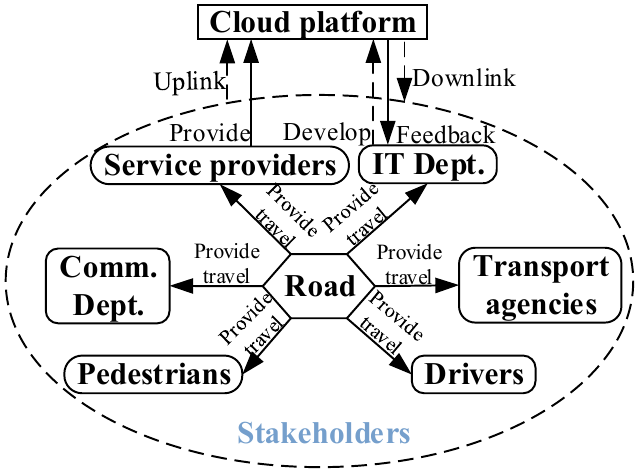
Figure 13. Function model of stakeholders. (c) Function modeling of the collision-warning service system Collisions usually occur between vehicles or between vehicles and pedestrians. We built the function model of the warning service system mainly based on these two aspects. The information sent from the sensing layer to the network layer is processed in Step 3 (a), and the modeling of the warning information function sent from the network layer to the application layer is followed.